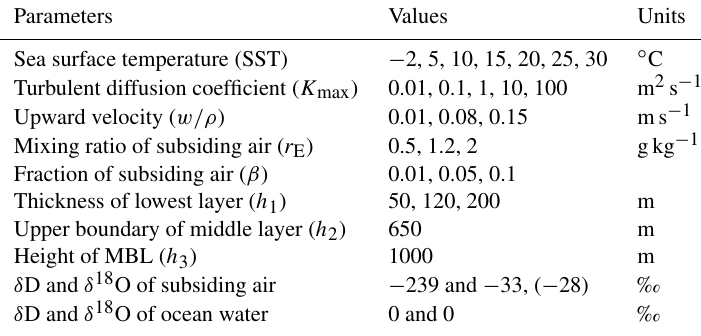
Table 4. Parameter values used in model verification